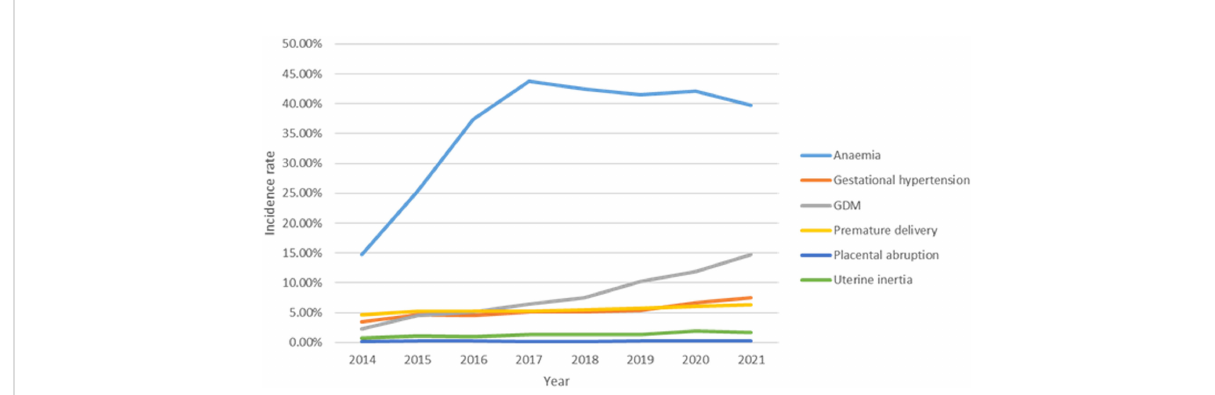
FIGURE 2 The prevalence of pregnant individuals with pregnancy complications from 2014 to